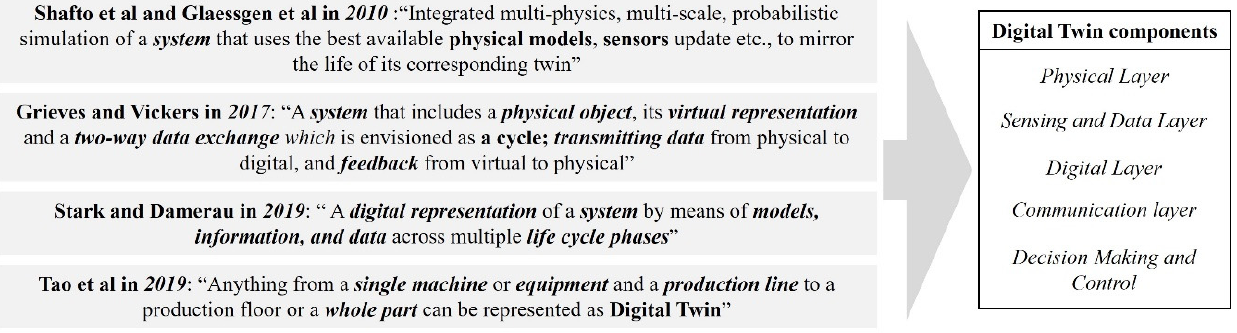
Figure 2. Digital Twin definitions and components [8–12].